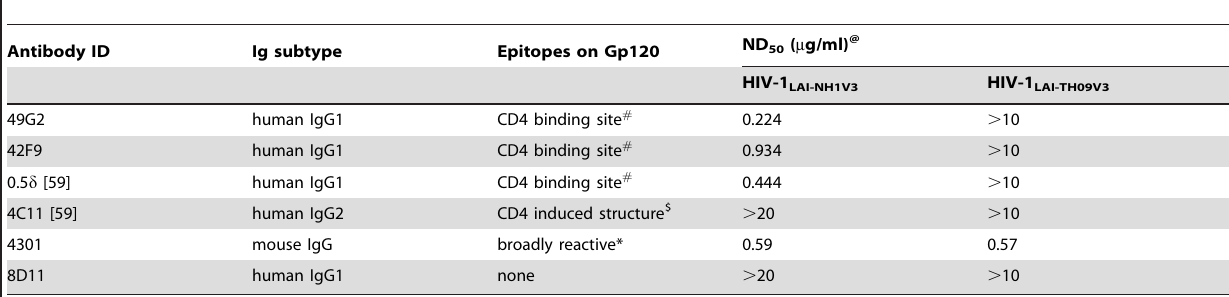
Table 1. Neutralization sensitivity of the isogenic V3 recombinant HIV-1 to anti-gp120 monoclonal antibodies.